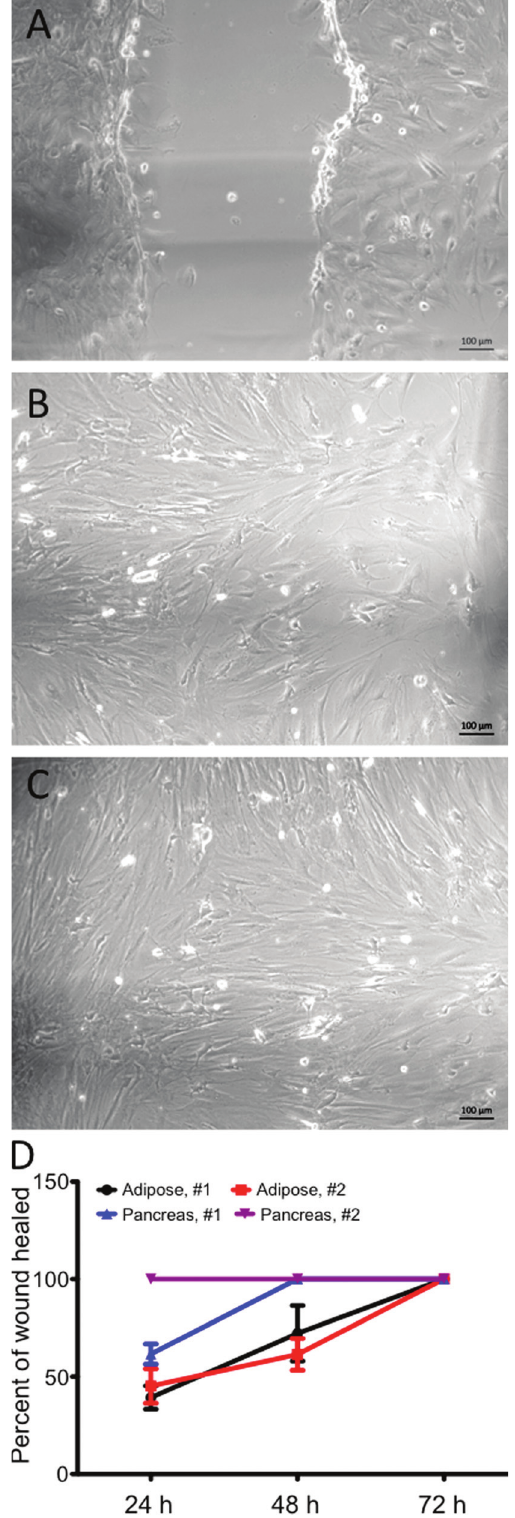
Figure5 - Invitro scratchassay.Migrationofcellsintoascratchproduced in adipose tissue and pancreas-derived cultures from two donors (#1 and #2)wasevaluatedbyimagesrecordedat0,24,48,and72h.Thepercentof closed scratch (or “healed wound”) was determined with ImageJ software. Values are mean (cid:4) standard deviation of three independent